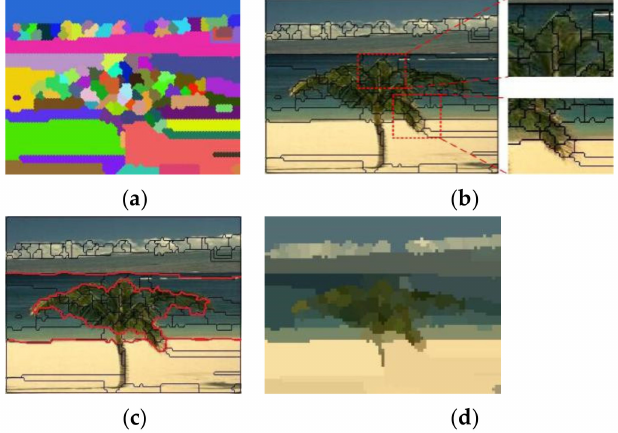
Figure 8. The results of the superpixel segmentation experiment. ( a ) The color blocks represent the different superpixels, ( b ) the black lines show the superpixel boundaries, ( c ) The red segmentation lines between the different salient regions, ( d ) The superpixel image.